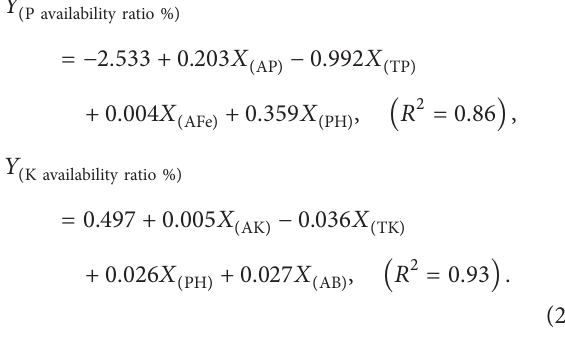
Figure 3. Spherical models are chosen for TN and ln ( AK ) , Gaussian models for ln ( TP ) , and ln ( AP ) , and exponential models for AN and ln ( TK ) . The nugget/sill ratio (𝐶 0 /(𝐶 +